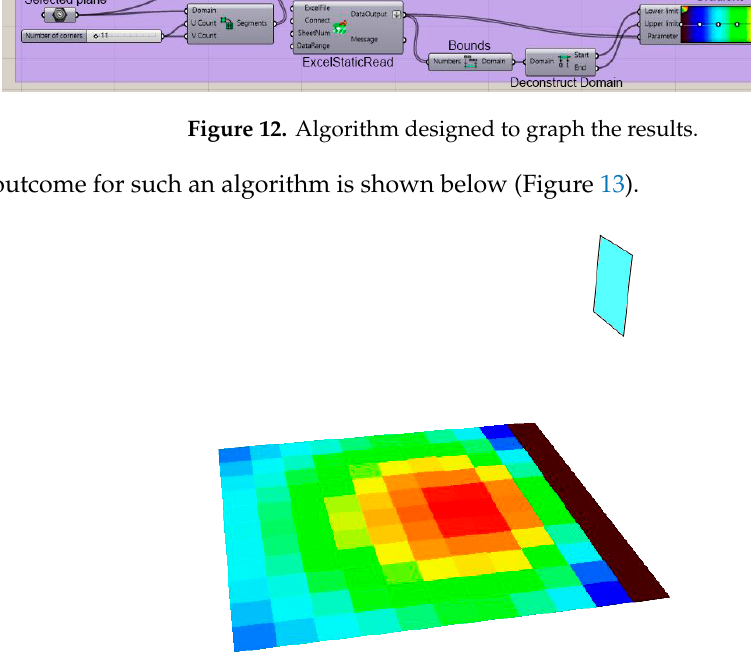
Figure 13. Color map of the configuration factor obtained by the discretization for each meter (110 values) of a horizontal area of 10 × 10 m 2 , illuminated by a ‘rectangle’ of 2 × 2 m 2 , 5 m above the ground and whose vertical axis coincides with the middle point of the horizontal surface.